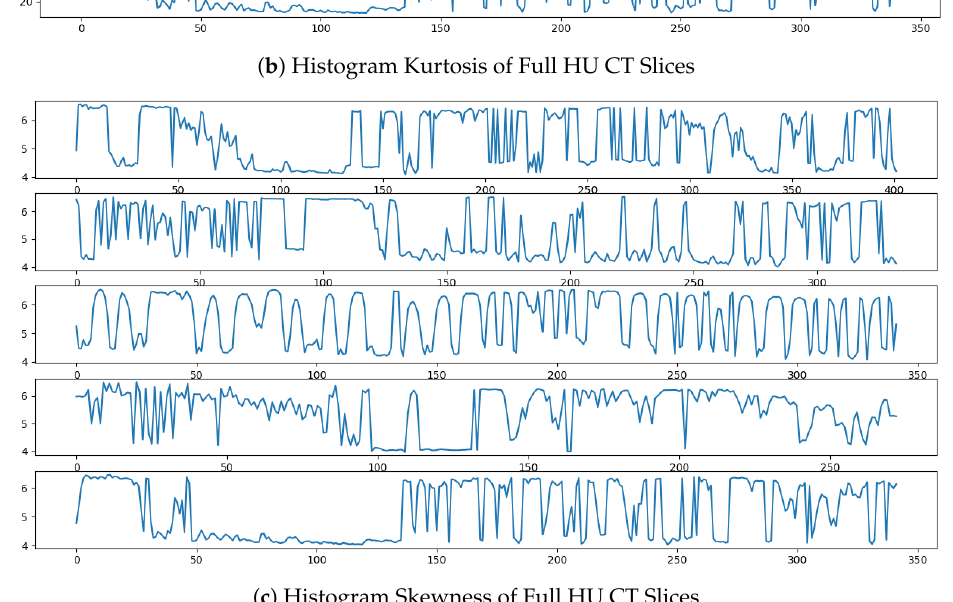
Figure 9. Histogram-based Features extracted from Full HU Bands CT